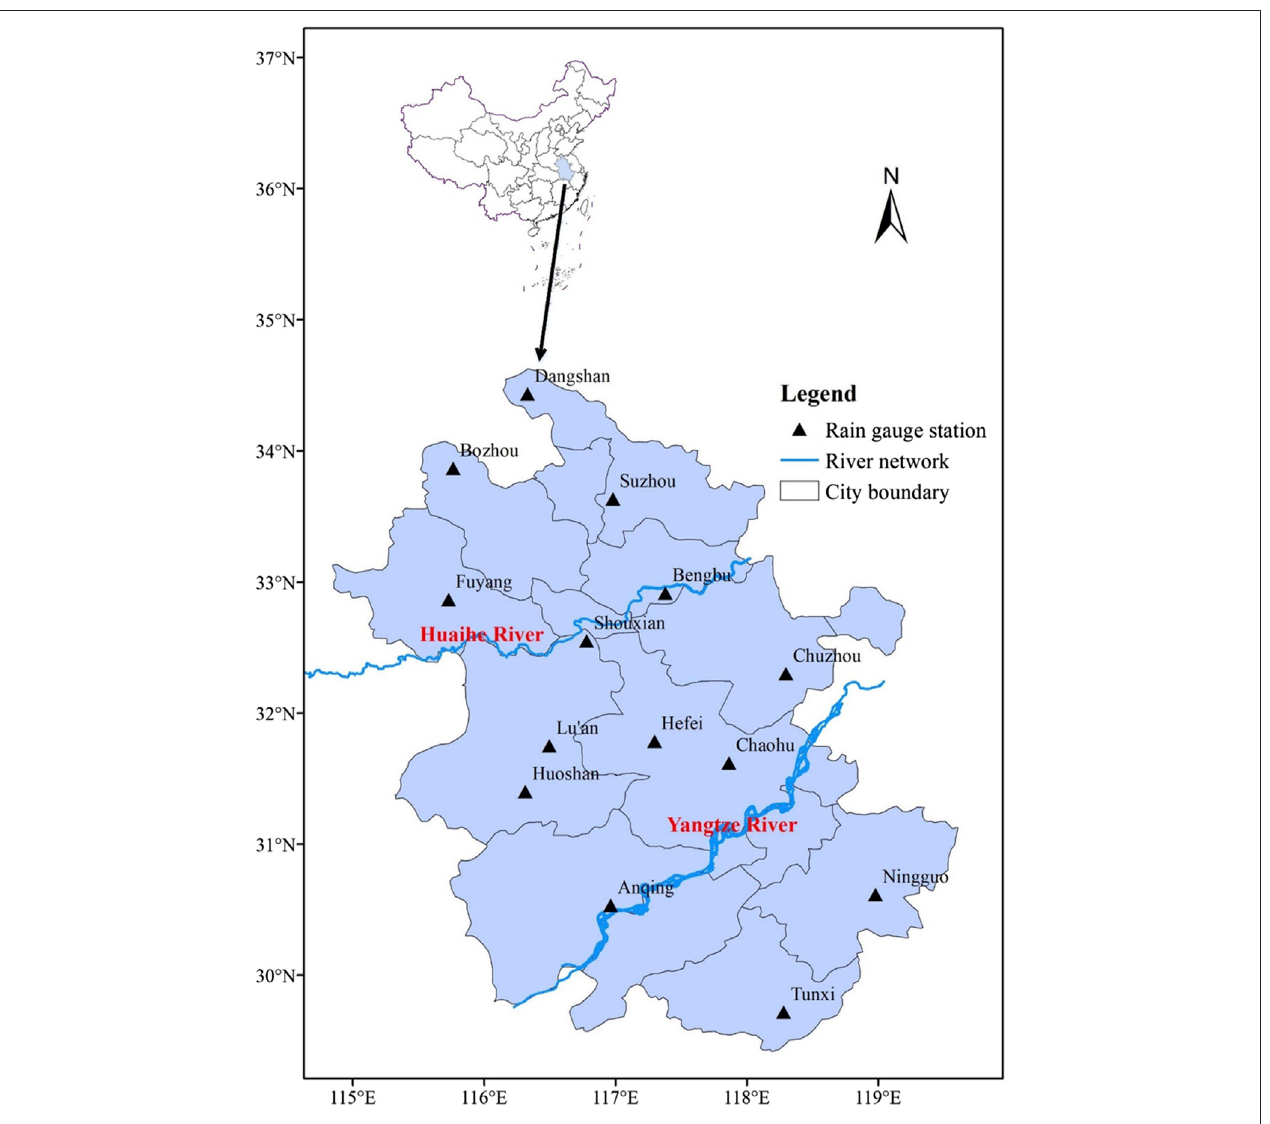
FIGURE 1 | Location of rain gauge stations in Anhui